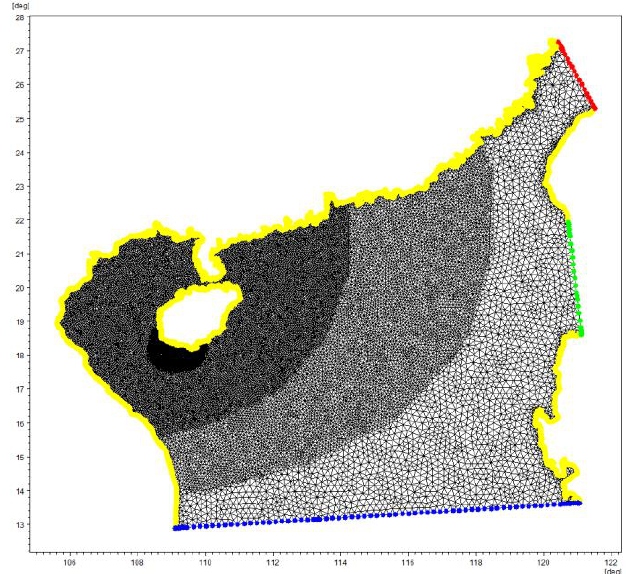
Figure 6. Range and mesh of the MIKE 21 SW